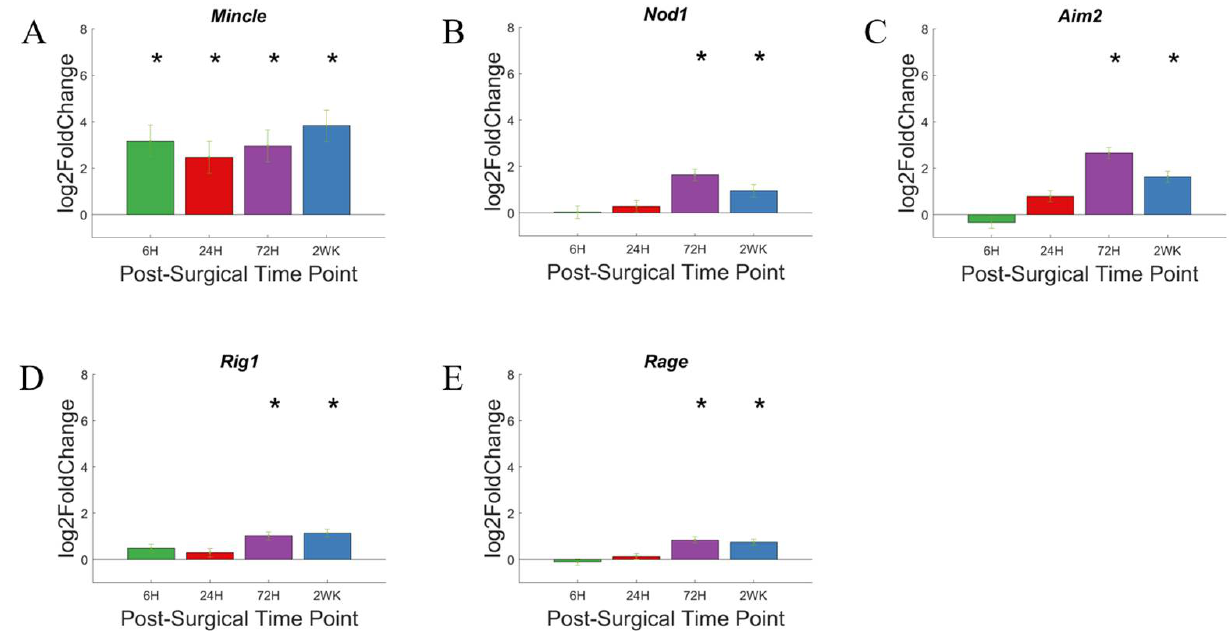
Figure 6. Differential expression of specific genes in the pattern recognition receptor family compared to NSCTR mice: All genes for the pattern recognition receptor except Toll-like receptors, which will be described in Figure 8. Gene set displayed as bar graphs of individual genes as a function of time post-surgery ( A – E ). For each time point, gene expression levels are compared to the NSCTR mice. Error bars indicate the standard error of the mean between NSCTR and each time point. Asterisks indicate that P adj <